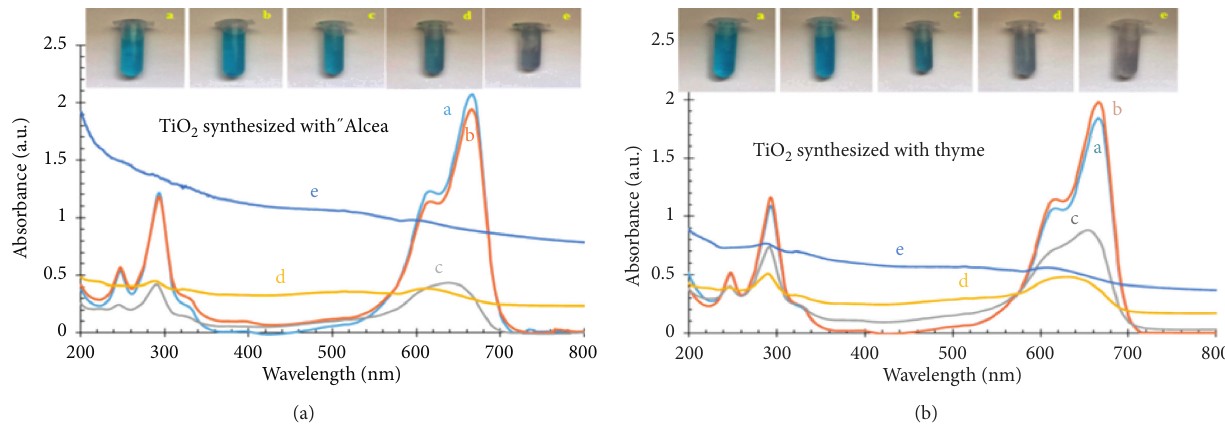
Figure 13: (a) Alcea- and (b) thyme-mediated biosynthesized TiO